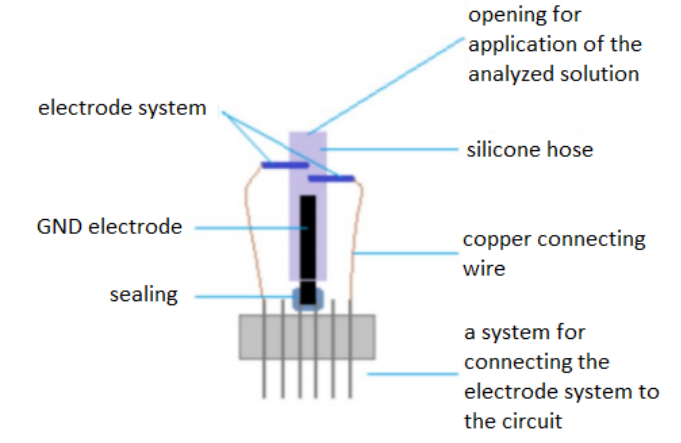
Figure 3. Construction of the